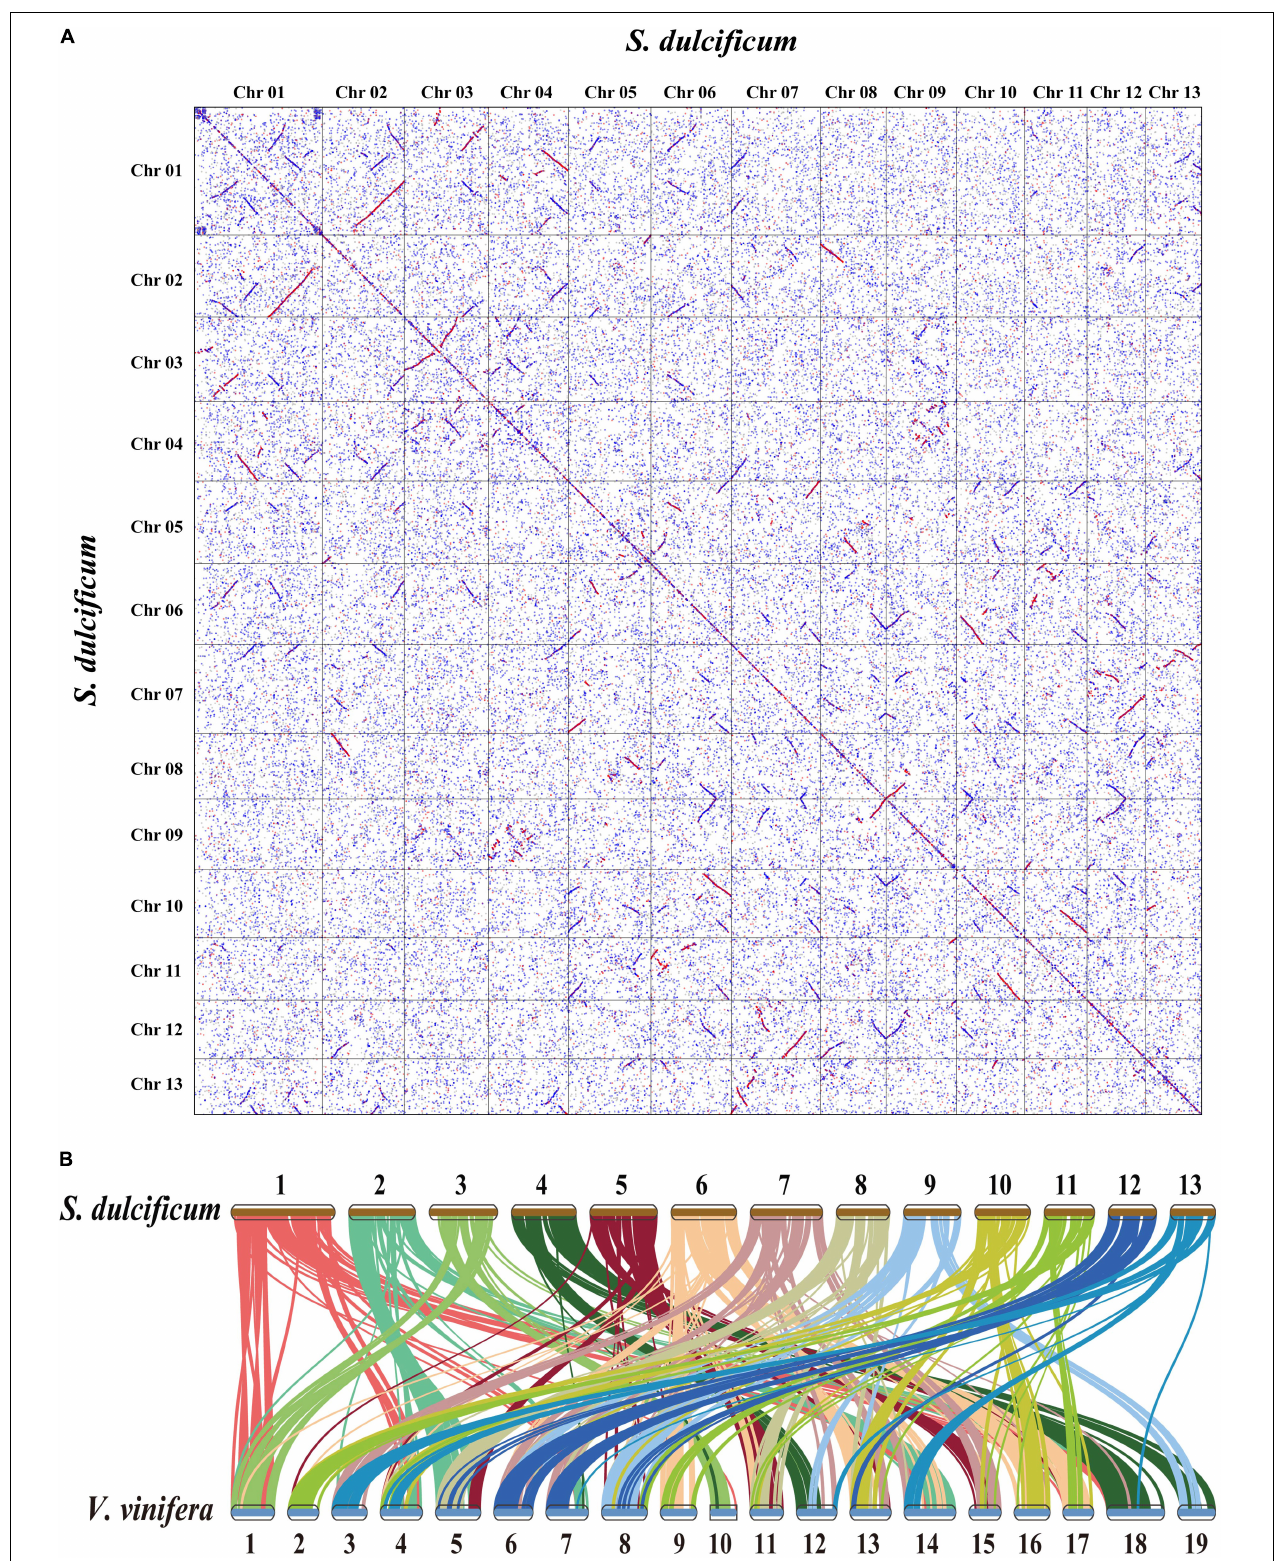
FIGURE 5 | Genomic synteny analysis between chromosomes of S. dulcificum , and between S. dulcificum and V. vinifera . (A) Dot plots of paralogs in S. dulcificum genome. (B) Collinear relationships between S. dulcificum and V. vinifera .